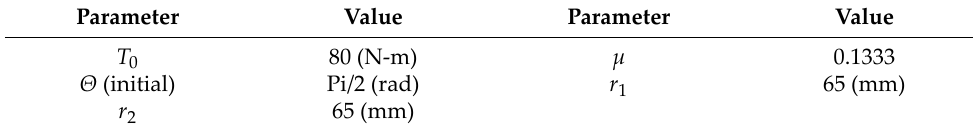
Table 2. List of physical parameters in